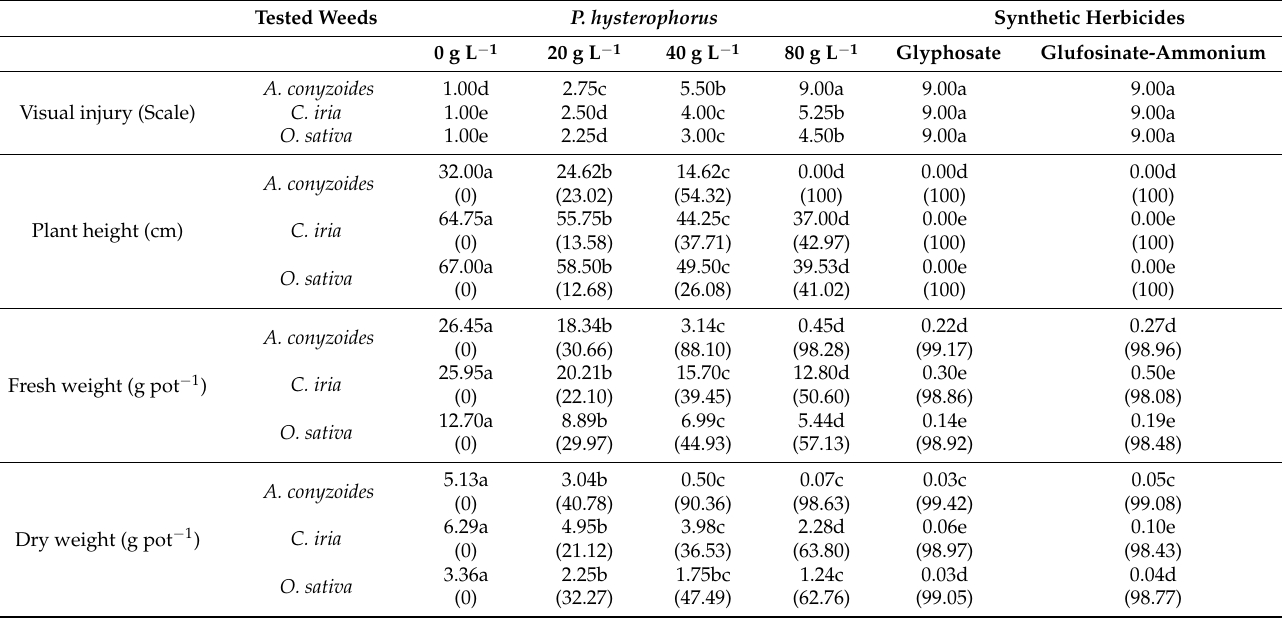
Table 5. Effect of P. hysterophorus on the visual injury, plant height, fresh weight and dry weight of A. conyzoides, C. iria and O. sativa.